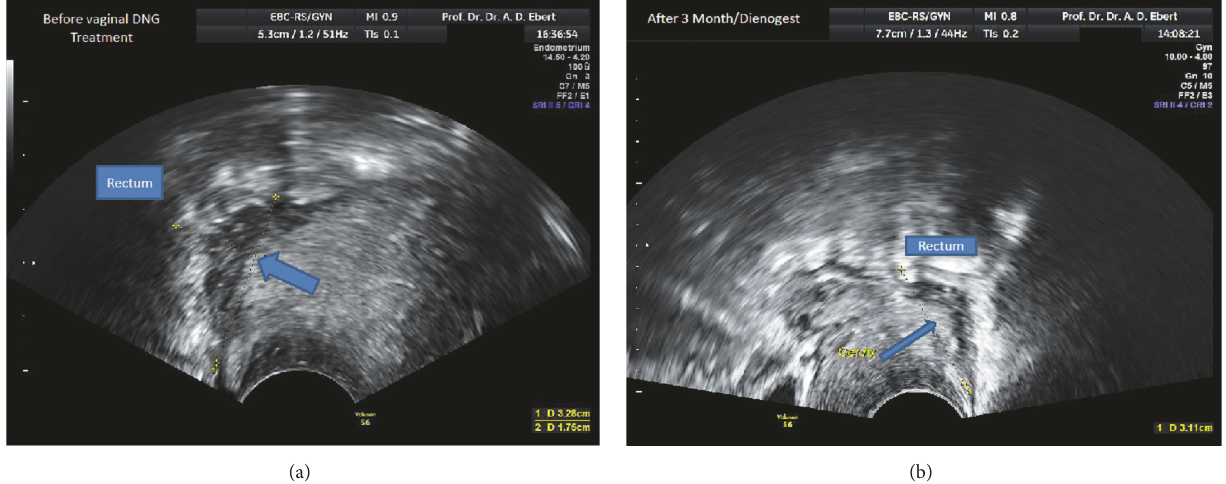
Figure 2: (a) Vaginal ultrasound appearance of the rectovaginal bowel involvement before the start of treatment in the symptomatic patient. (b) No change in the vaginal ultrasound findings after 3 months of vaginal dienogest administration (2mg/d) in the patient who was now de facto